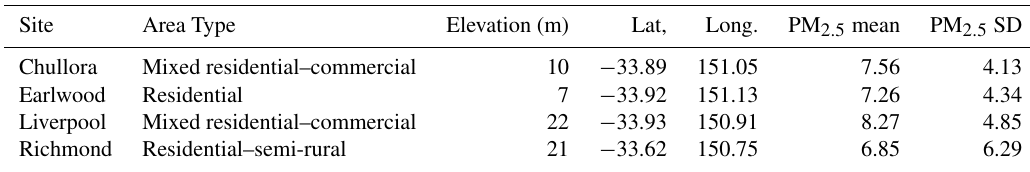
Figure 1. Locations of meteorological and PM 2 . 5 monitoring stations in the New South Wales Office of Environment and Heritage network in Sydney, Sydney Airport meteorological station, and Bureau of Meteorology (BoM) stations (with station numbers) from which rainfall data were obtained. Table 1. The area type, elevation, location, inter-annual (2005–2016) mean and standard deviation (SD) PM 2 . 5 concentration (µgm − 3 ) of each monitoring